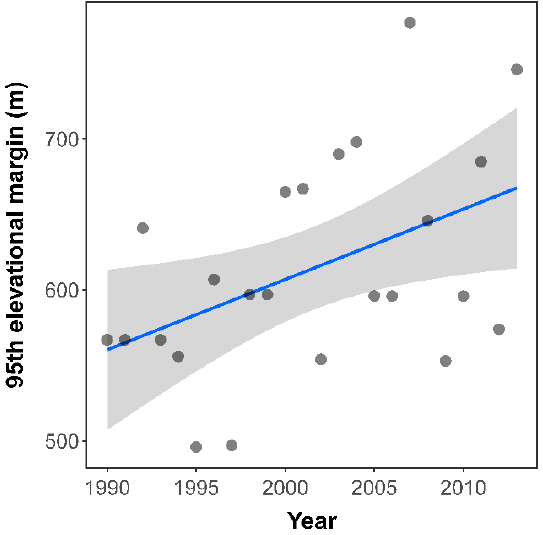
Figure 1. Historical changes of the leading elevational edge (95th percentile) of Sympetrum striolatum in Switzerland between 1990 and 2013. The linear regression was positively significant (R 2 = 0.21, p = 0.02), suggesting a historical shift towards higher